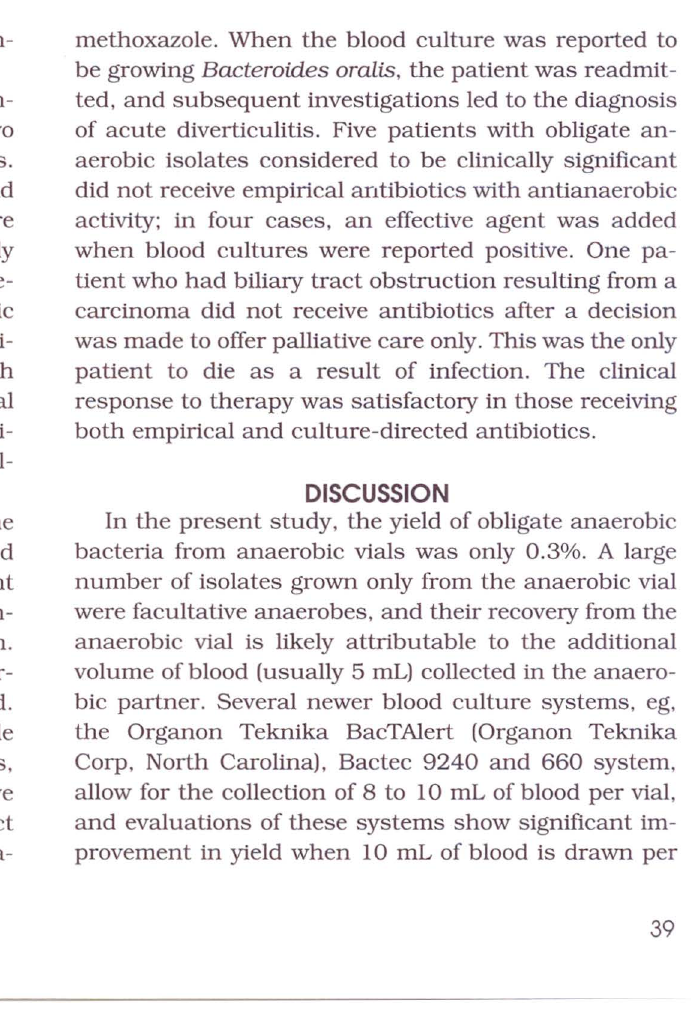
Abdominal pain. cervical